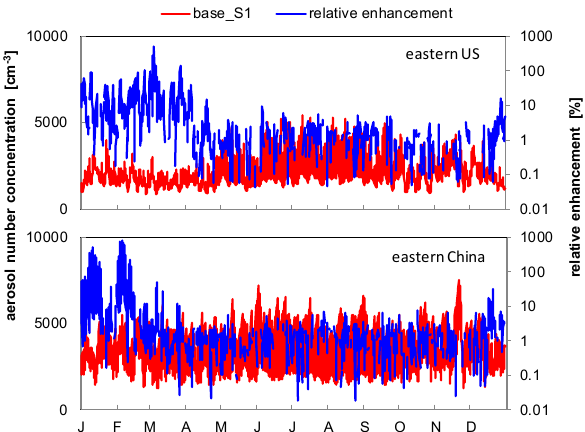
Fig. 10. Simulated aerosol number concentrations and the relative enhancement related to simulating realistic HONO levels near the surface over the eastern US (95–65 ◦ W and 30–50 ◦ N, upper panels) and China (100–130 ◦ E and 25–55 ◦ N, lower